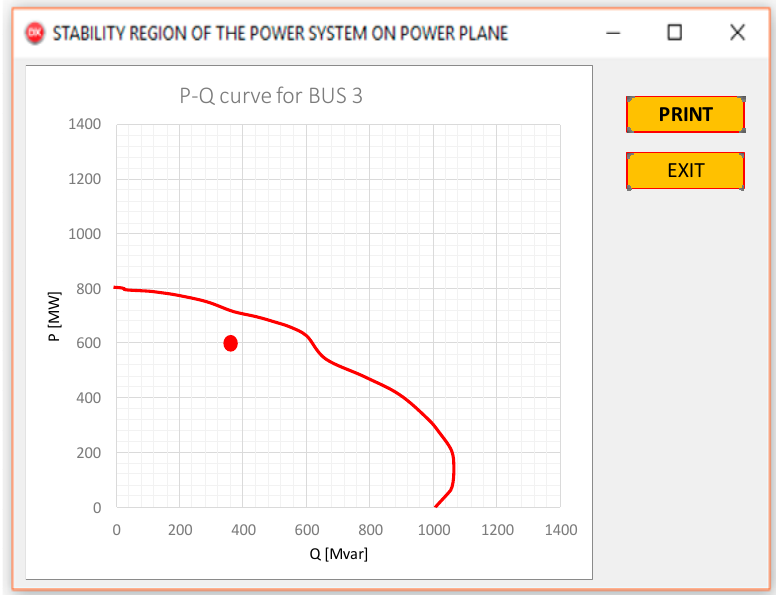
Figure 14. Operating region at Bus 3 when adjusting the load at Bus 6.